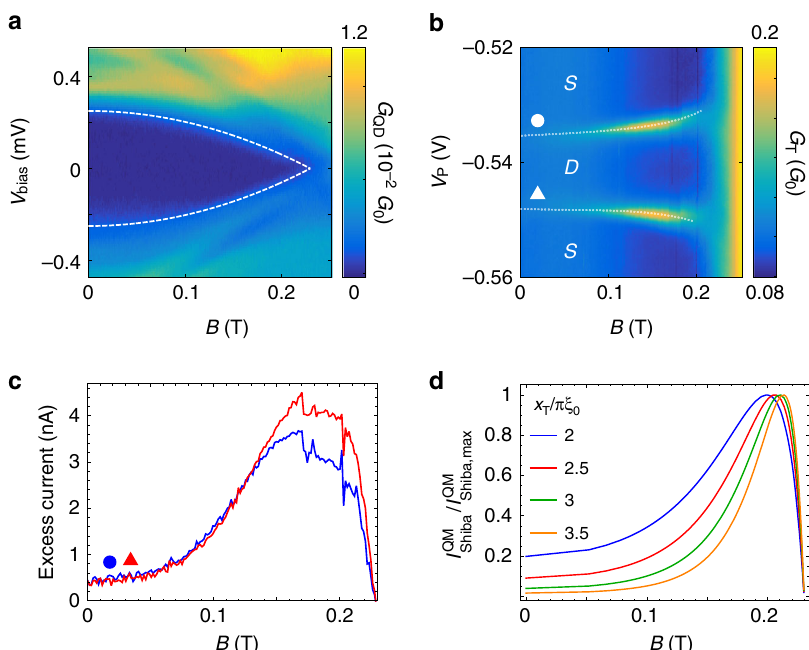
Fig. 4 Giant increase of the tunnel conductance in magnetic fi eld. a Reduction of the superconducting gap with increasing magnetic fi eld measured at V 0 : 7 V, V 0 : 6 V. The dashed line shows the fi t with Eq. (3). b Evolution of the conductance enhancement with magnetic fi eld measured along P ¼ (cid:3) B ¼ (cid:3) the dashed line on Fig. 3a. The gray dotted lines are guides to the eye. c The excess current (spectral weight) associated with the zero-energy Shiba state on panel b . The curves show the integrated excess tunnel conductance, Δ G V , after subtracting the V independent background conductance. For the T ð P Þ P red/blue curve the integration along V was carried out for resonance marked by triangle/circle on panel b . The integration window was converted to P energy by the level arm of the dot. d NRG simulation of the excess current in the tunnel probe for different ratios of the distance between the dot and the tunnel probe, x and the zero fi eld coherence length of Pb, ξ 0 using ε U = T d ¼ (cid:3)